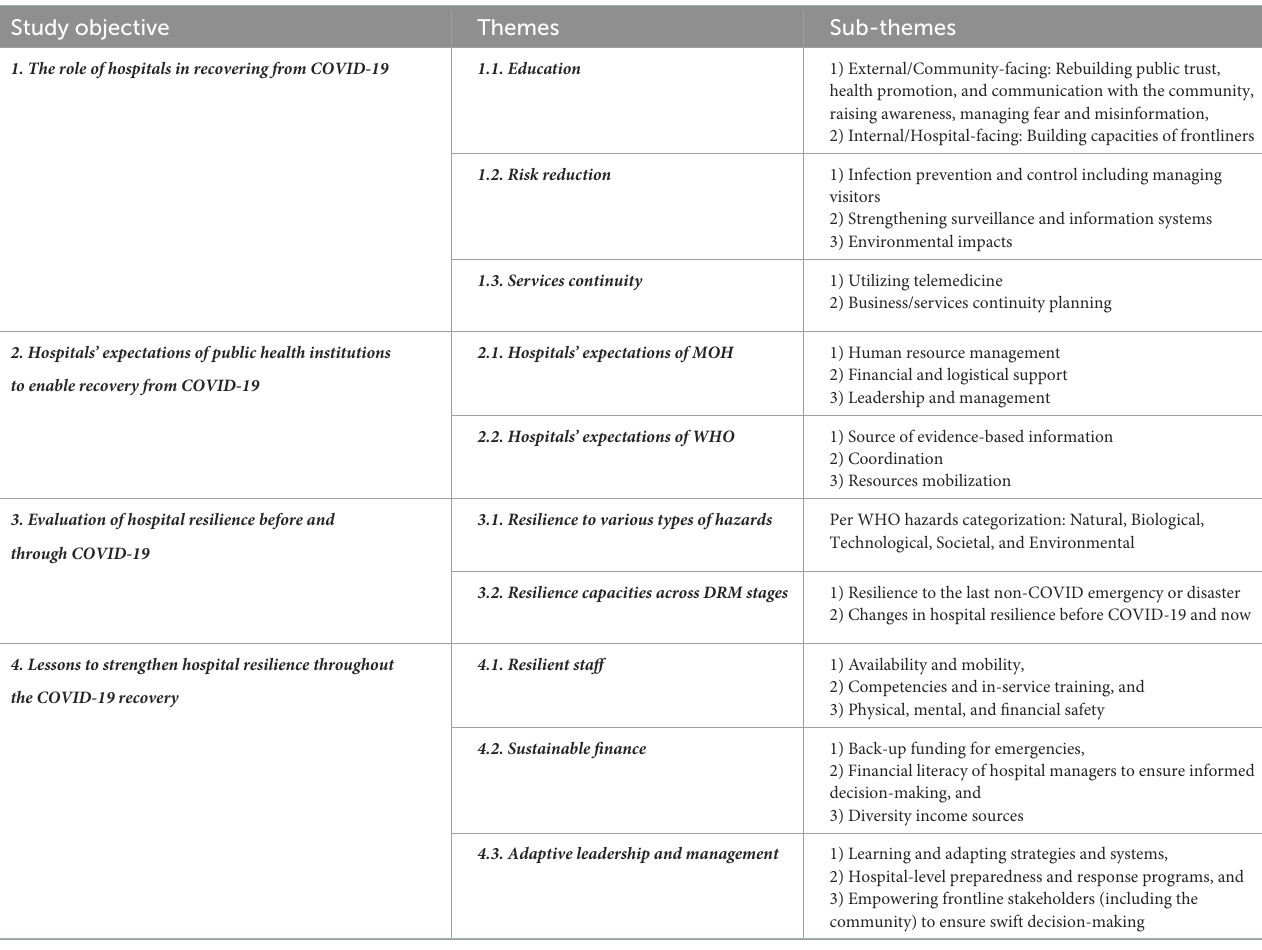
TABLE 1 Themes and sub-themes by study